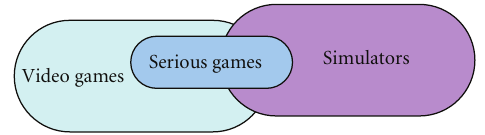
Figure 1: Relation between video games, simulators, and serious